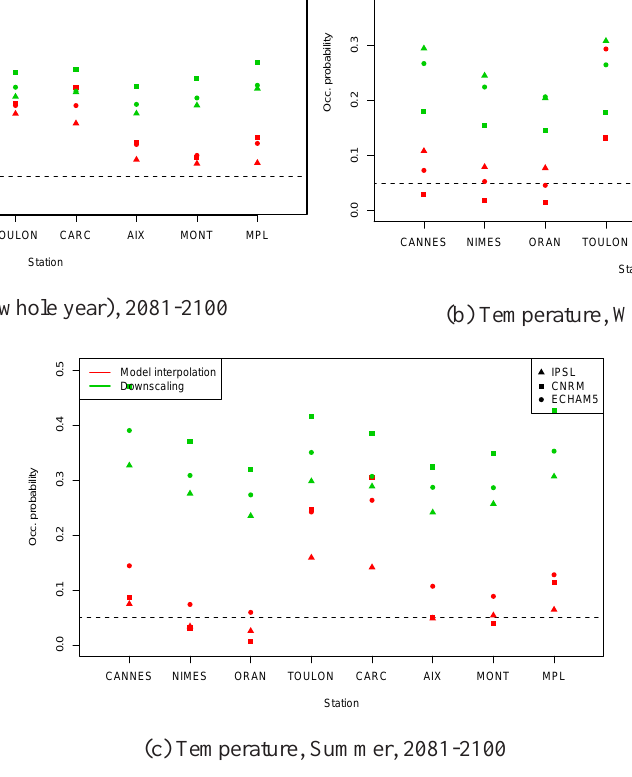
Fig. 8. Same as Fig. 6 for wind